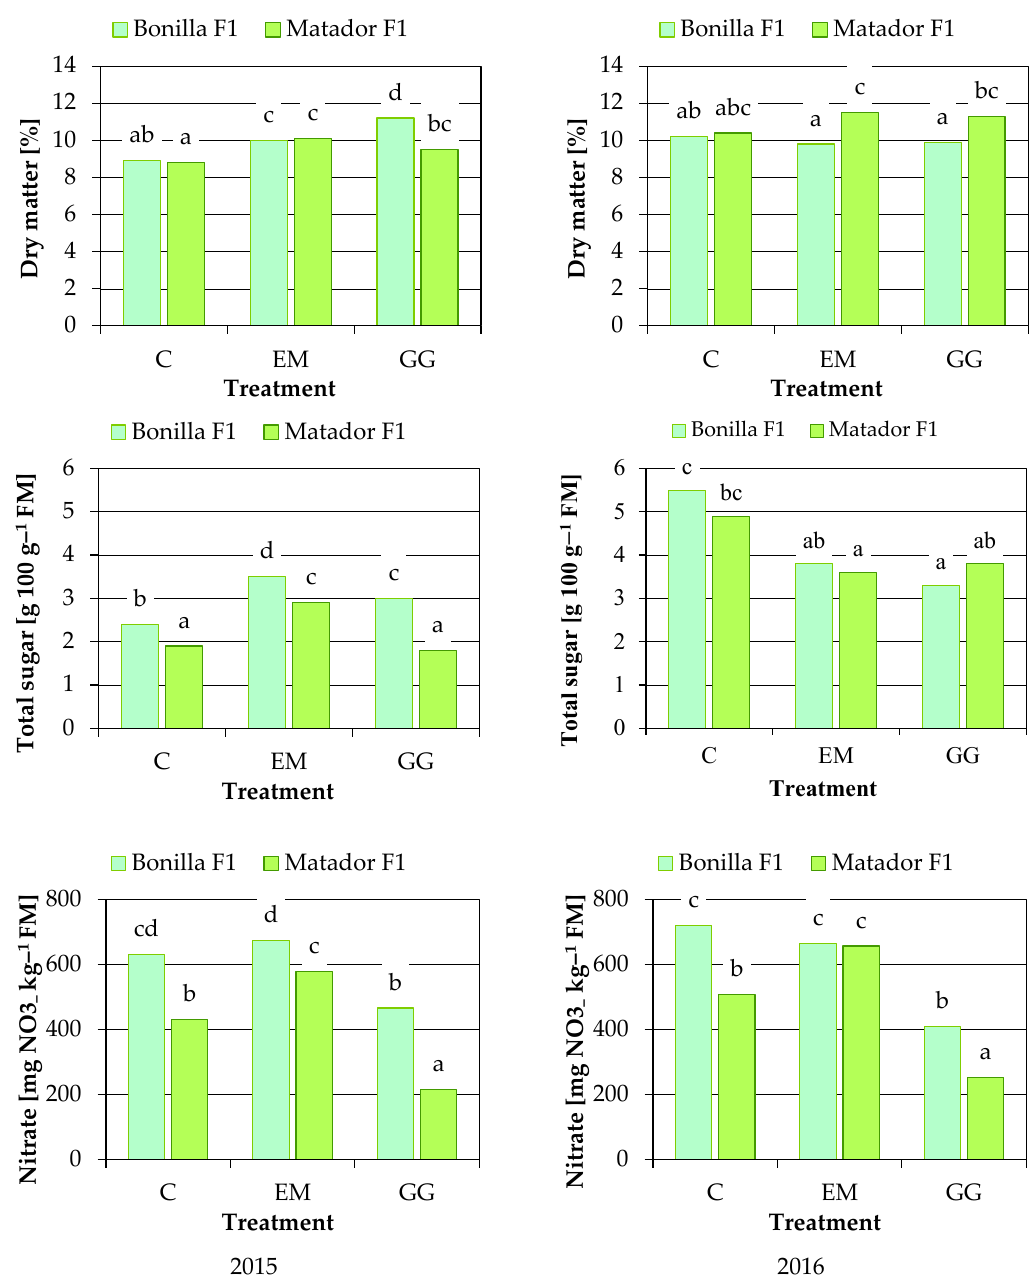
Figure 4. Chemical composition of shallot leaves. Means followed by different letters are significantly different for each parameter. C—control treatment, EM—1% solution of Effective Microorganisms, GG—0.1% solution of Goëmar Goteo.